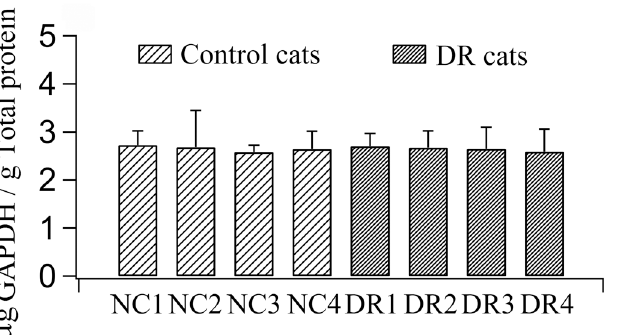
Fig 9. The quantity of GAPDH protein measured with enzyme linked immunosorbent assay. The quantity was expressed as a relative value of GAPDH ( μ g) to total proteins (g) in V1 samples of each normal control cat (NC1, NC2, NC3, NC4) and DR cat (DR1, DR2, DR3, DR4). Assays for each subject were performed in triplicate. The mean content in DR cats showed no significant difference from that in control cats (F(1,8) = 0.02, p >